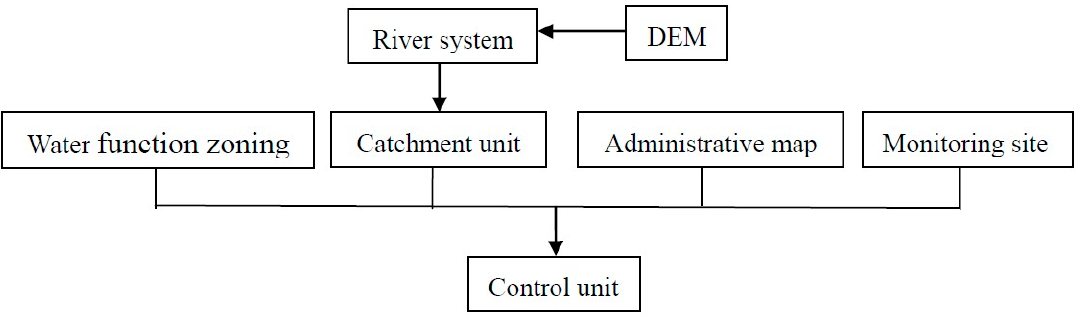
Figure 2. Schematic diagram of control unit division.